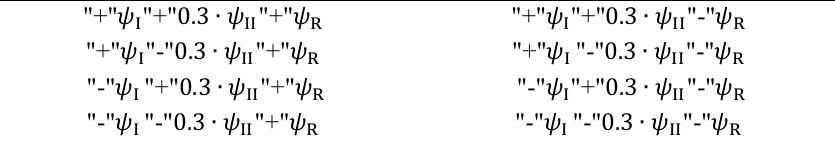
Table 2 . Earthquake Spatial Action of simultaneous floor enforced-displacements, where the displacement along axis 𝐼 is maximized (index sec has been omitted). sec Eight (8) enforced-displacement combinations of non-linear static